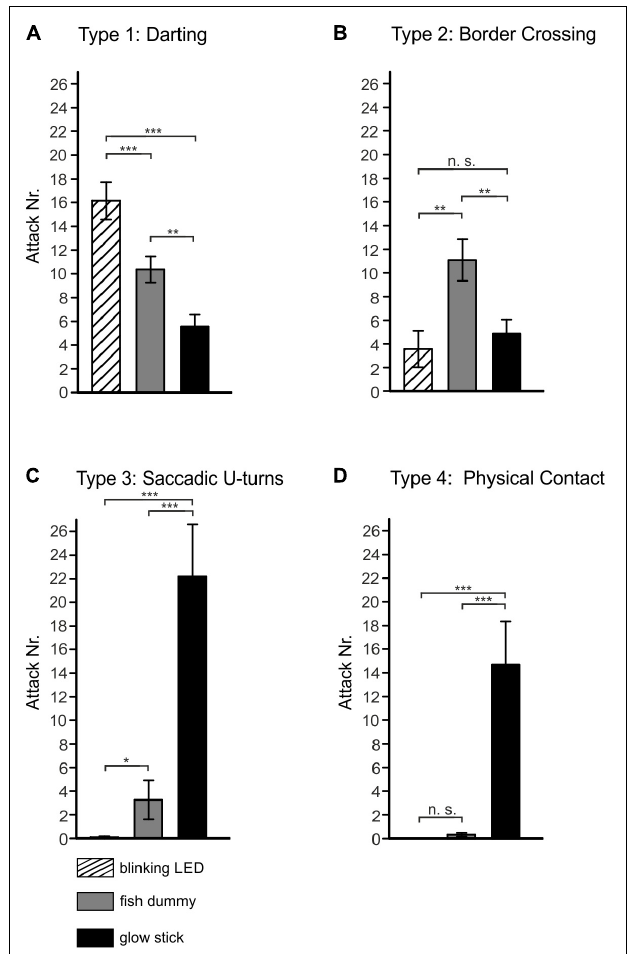
FIGURE 4 | Aggression behavior in Photoblepharon steinitzi during exposure to fish and light organ dummies. Analysis of the aggression behavior of P. steinitzi during exposure to light organ and fish dummies, i.e., blinking LED, fish dummy, and glow stick. Four different types of aggression behavior in P. steinitzi were observed. All types of aggression were correlated with an increase in blink frequency. (A) Type 1: Darting swimming profile in the periphery. (B) Type 2: Border crossing between periphery and center of caves. (C) Type 3: Repeated swimming directly in stimulus direction followed by saccadic U-turns into the opposite direction. (D) Type 4: Aggressive physical contact with hit and bite reactions. Shaded bars indicate trials with an artificial blinking (1 Hz) light organ. Gray bars indicate trials with a fish dummy with constant glowing light organs. Black bars indicate trials with an artificial constant glowing light organ dummy. Error bars indicate mean ± SEM. Significance values are reported as: * p ≤ 0.05; ** p ≤ 0.01; *** p ≤